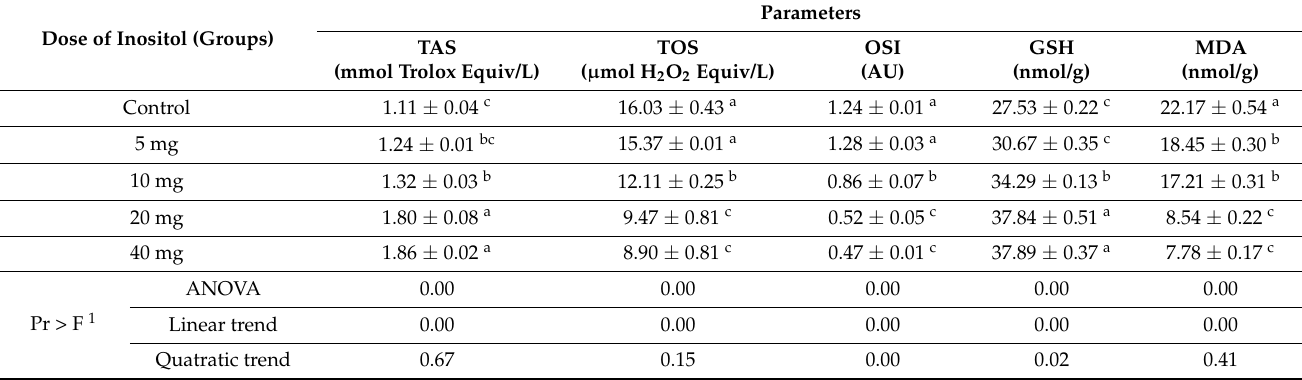
Table 2. Oxidative stress status of S. triostegus sperm after thawing (mean ± SE, n = 7). Dose of Inositol